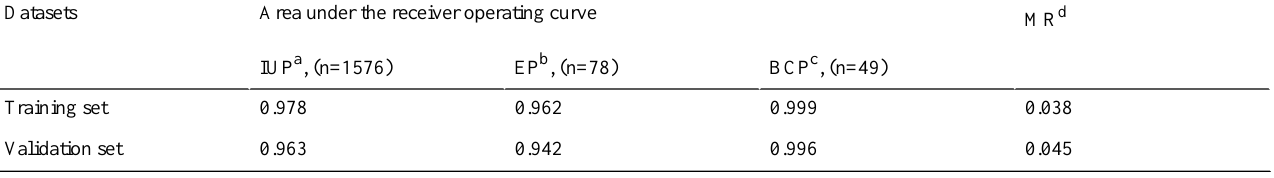
Table 2. The performance of the predicting model.